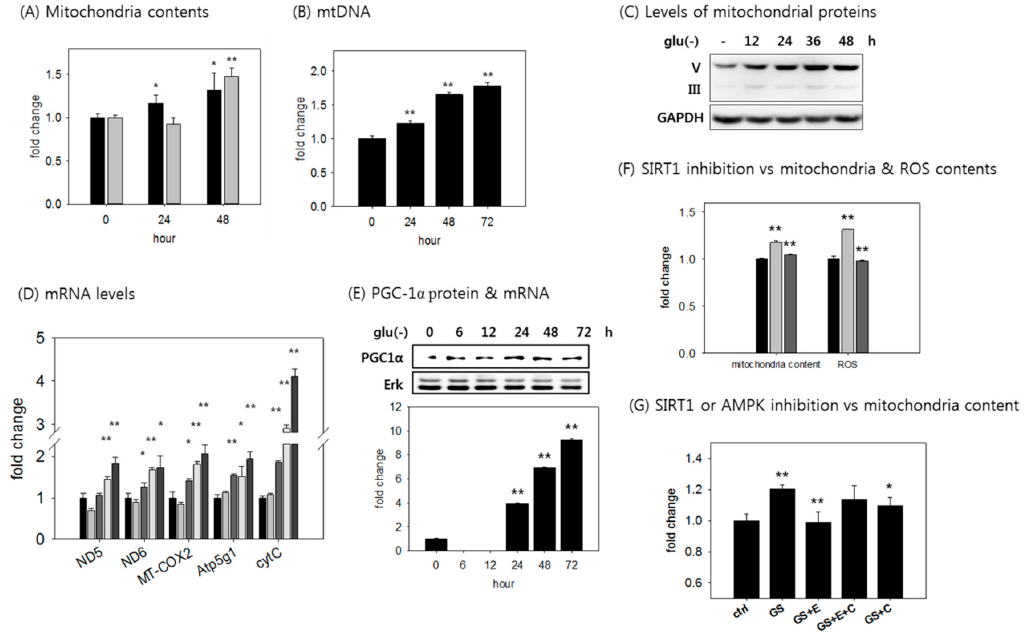
Figure 4. Increased mitochondrial content resulting from elevated mitochondria biogenesis through SIRT1 activation. ( A ) Fibroblasts were incubated in glucose-free medium for the indicated time period, and analyzed by flow cytometry. Mitochondrial content was detected by staining with MTG (black bar) or NAO (grey bar); ( B ) mitochondrial DNA copy number was determined by qPCR. Genomic DNA was isolated, and the relative mtDNA amount was measured by qPCR normalized against the amount of nuclear DNA; ( C ) mitochondrial electron transport chain complex III or V was detected in cells incubated in glucose-free medium by immunoblotting with OXPHOS cocktail antibody; ( D ) transcription of three genes encoded by the mitochondrial genome, NADH dehydrogenase, subunits 5 and 6 (ND5, ND6), and cytochrome c oxidase subunit II (MT-COX2), and two genes encoded by the nuclear genome, ATP synthase lipid-binding protein (Atp5g1) and cytochrome c, were measured by qRT-PCR. Cells were incubated without glucose for four days, and then lysed. The means of three biological repeats of the control, and 24, 48, 72, and 96 h deprivation are indicated as the bars in order; ( E ) PGC-1 α protein expression was detected by immunoblot analysis and confirmed by qRT-PCR; ( F ) cells were glucose deprived for three days, and mitochondrial content or mitochondrial superoxide was determined by staining with MDR or mitoSOX and analysis by flow cytometry. Black bar; control, light grey bar; glucose withdrawal, dark grey bar; glucose withdrawal and 10 μ M EX527 treatment; ( G ) cells were glucose deprived for three days and treated with 10 μ M EX527 (GS + E) or 2 μ M compound C (GS + C), or both (GS + E + C) for the last 12 h. Mitochondrial content was determined by staining with MDR, and analyzed by flow cytometry. All results from flow cytometry are the means of at least two biological repeats of more than 1 × 10 4 cells. Values are presented as mean ± s.d. *, p < 0.05, ** p < 0.01 by ANOVA.